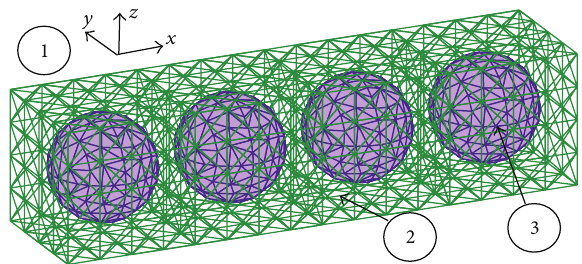
Figure 5: For convergence study, LEGO model with 𝑁 𝐷 = 4 bricks of a linear arrangement of four dielectric spheres. Data : brick’s edge 10cm, sphere’s radius 4 cm, 𝜀 1 = 𝜀 2 = 𝜀 0 , and 𝜀 3 = (4̂ x ̂ x +2̂ y ̂ y +2̂ z ̂ z )𝜀 0 .